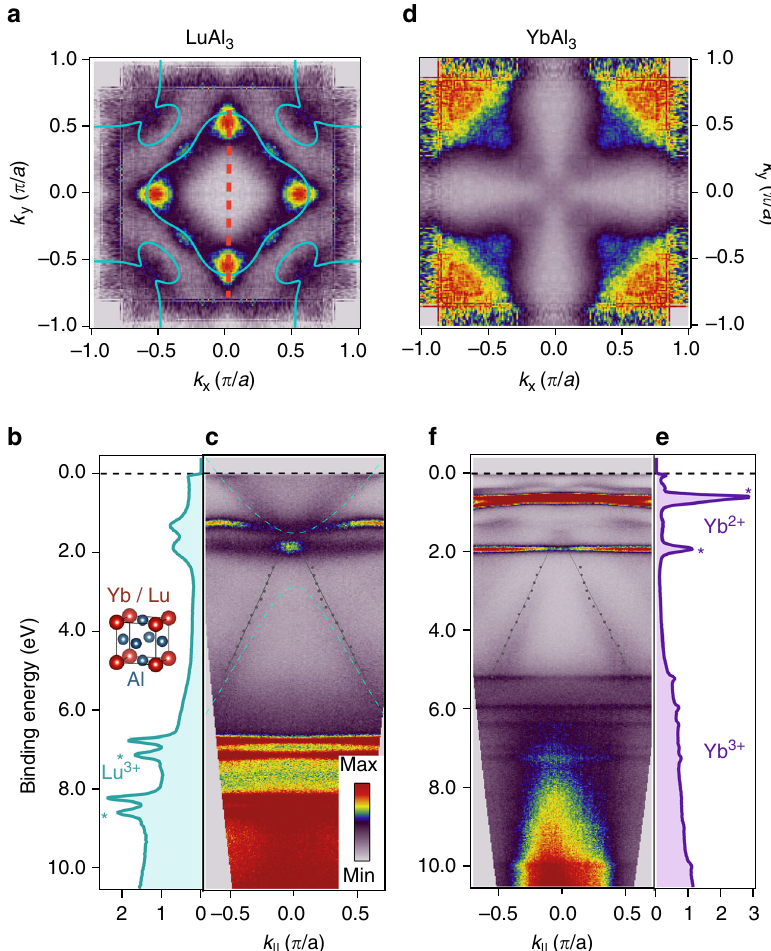
Fig. 1 Electronic structure and Fermi surfaces of YbAl 3 and LuAl 3 . Fermi surface maps and energy distribution curves (EDCs) and E vs. k dispersion for a – c , LuAl 3 and d – f , YbAl 3 , all measured with h ν = 21.2 eV at 21 K. Experimental Fermi surfaces of a , LuAl 3 and d , YbAl 3 . DFT calculations (green lines) of the Fermi surface topology at k z = 0 for LuAl 3 with U = 0 are overlaid in a . Momentum-integrated EDCs of b , LuAl 3 and e , YbAl 3 , with surface core levels marked as asterisks. E vs. k dispersions for c , LuAl 3 and f , YbAl 3 , together with DFT calculations of the band structure in LuAl 3 (green) shown in c . The similarity between the dispersion of the light band between 2 and 6 eV in YbAl 3 and LuAl 3 suggest that both compounds have similar inner potentials, and that both measurements are at k z = 0 ± 0.1 π /